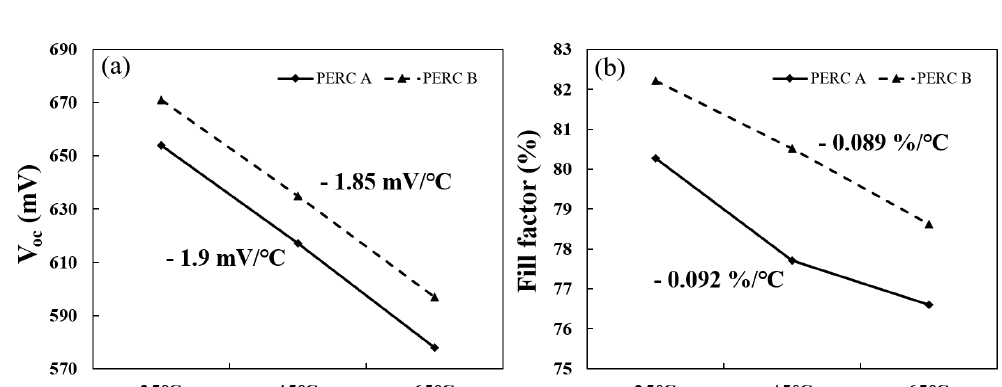
Table 1. Results of illuminated J-V measurement and n factor (from Suns- V oc ) of PERC A and B according to temperature dependence.